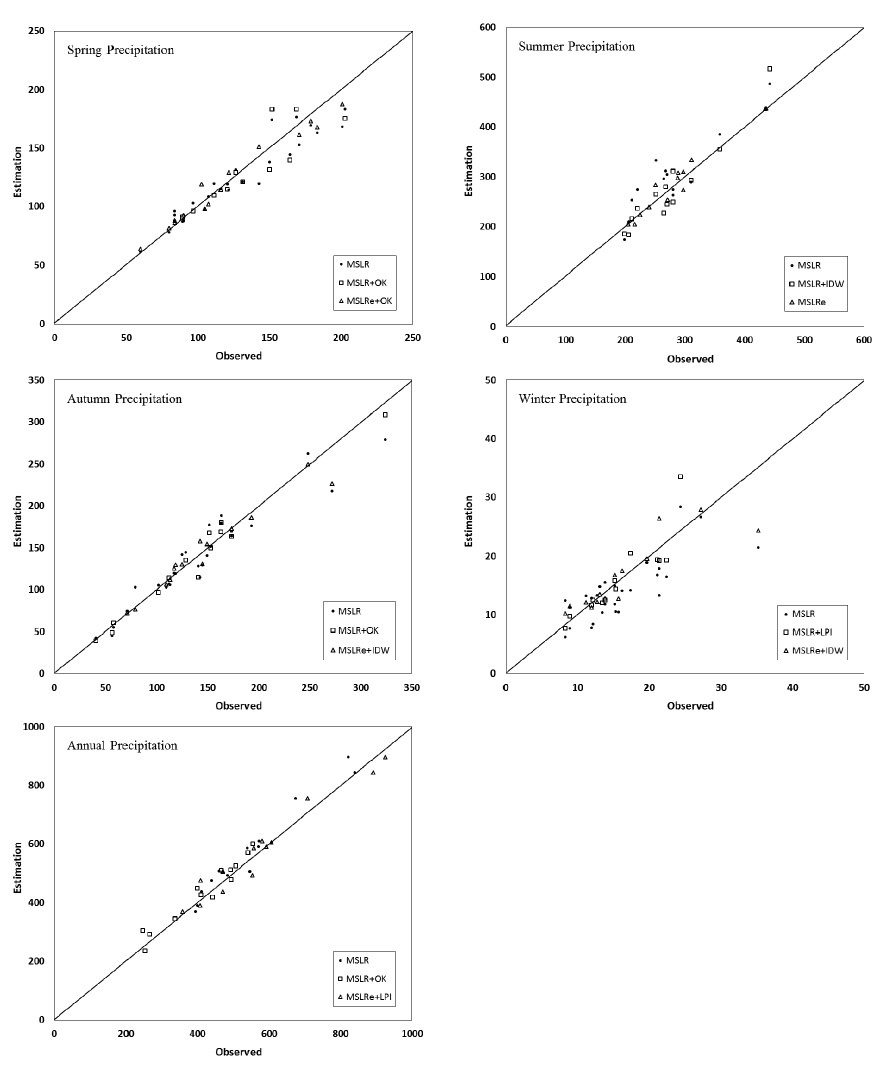
Figure 3. Scatter distribution of estimated and observed annual and quarterly precipitation values.